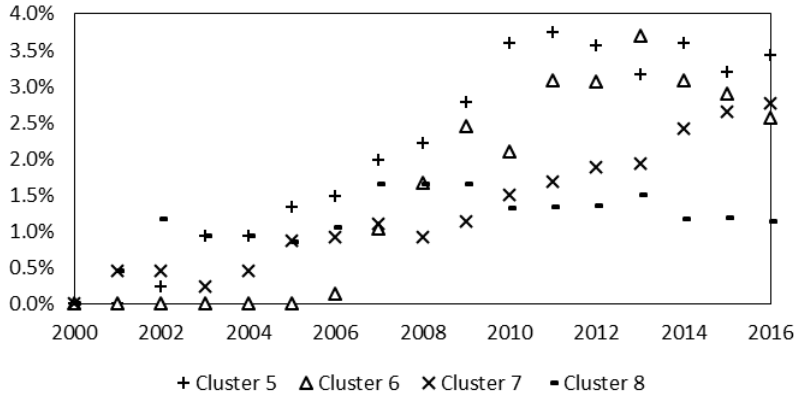
Figure 6. Yearly trends in publishing per cluster. Clusters 5–8: emotion detection, assessment of robotic surgery, robots for the elderly and telepresence and human-robot interaction in rescue robots.